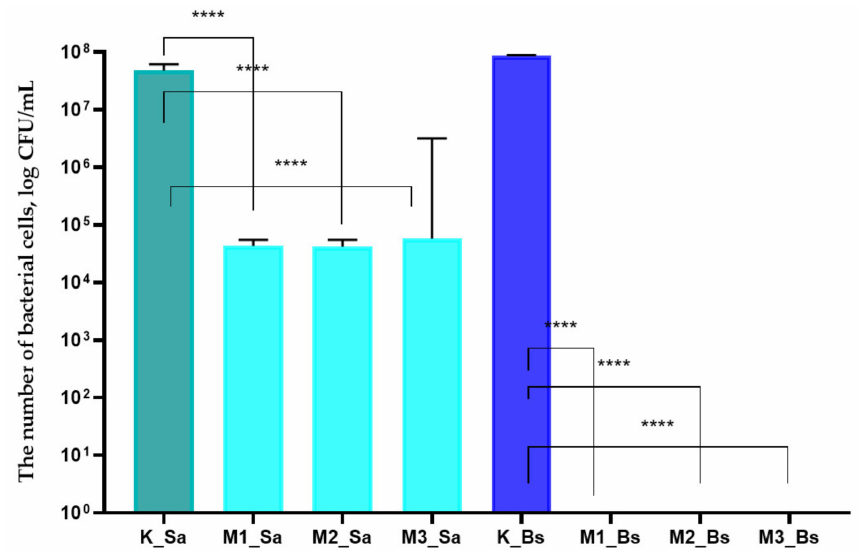
Figure 6. The influence of coatings on S . aureus and B. subtilis growth. K_Sa—PE film—control sample (Sa—incubated with S. aureus ); M1_Sa—PE film covered with the MHPC coating containing 25% of mixture M1 as active compound; M2_Sa—PE film covered with the MHPC coating containing 25% of mixture M2 as active compound; M3_Sa—PE film covered with the MHPC coating containing 25% of mixture M3 as active compound; K_Bs—PE film—control sample (Bs—incubated with B. subtilis ); M1_Bs—PE film covered with the MHPC coating containing 25% of mixture M1 as active compound; M2_Bs—PE film covered with the MHPC coating containing 25% of mixture M2 as active compound; M3_Bs—PE film covered with the MHPC coating containing 25% of mixture M3 as active compound. One-way ANOVA: ****— p < 0.0001.